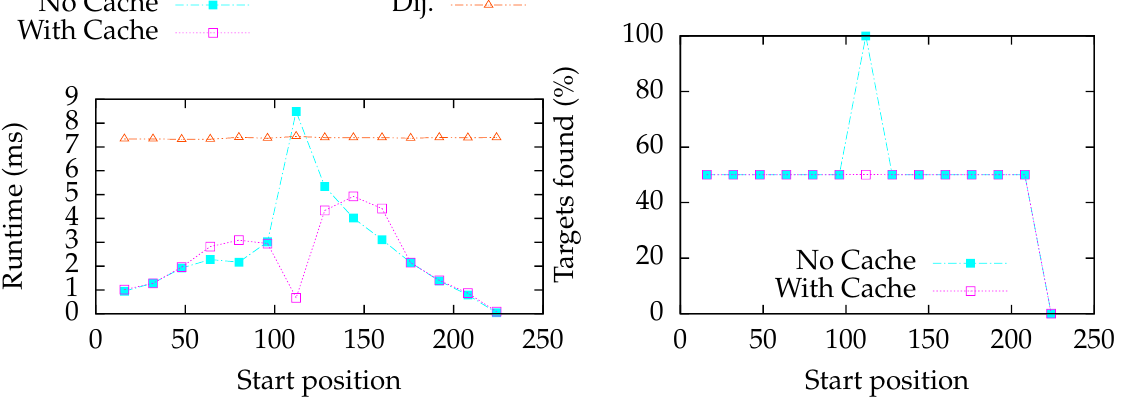
Figure 8. Evaluation on a line graph with two target vertices u and v having the indices 0 and 250, respectively. We promote vertices with an index from 10 to 225 to the query vertex s ; the x -axis reflects this index (i.e., the start position is the index of the start vertex). Naive measures the time for Dijkstra’s algorithm to find the shortest paths to all target vertices. The curves No Cache and With Cache measure our solution when running the computation without cache and running the computation with the node in the middle of the line graph cached, respectively.